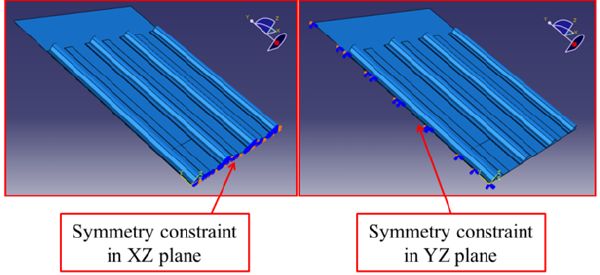
Figure 8: Loads and constraints on the quarter of the panel